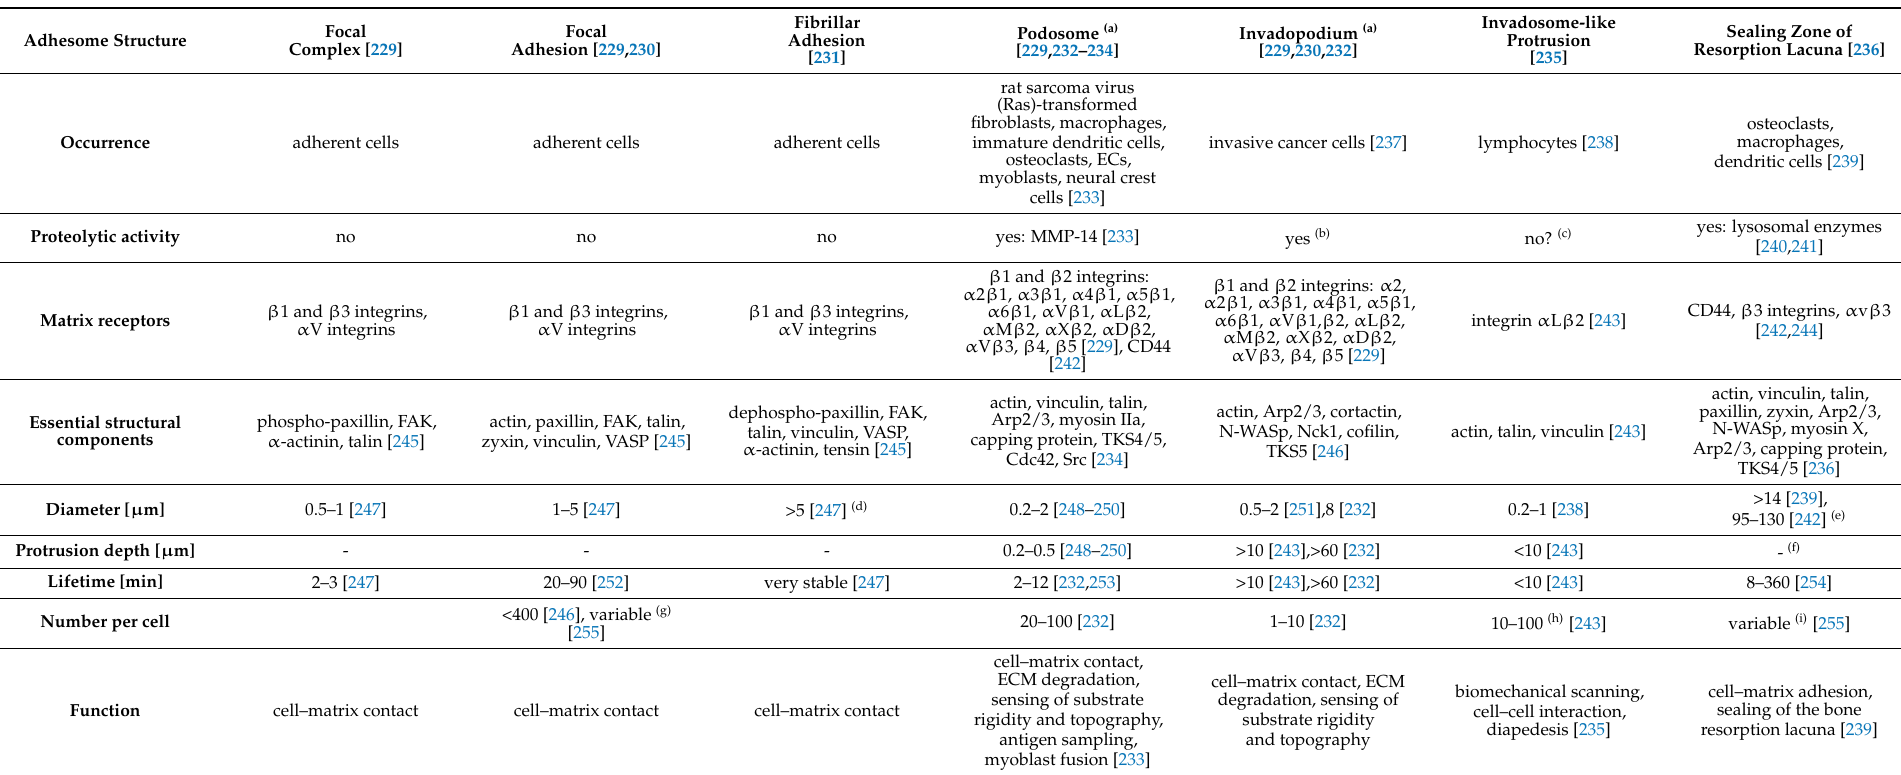
Table 2. Overview of cell–matrix adhesion structures and their involvement in pericellular proteolysis. Cells interact with their surrounding matrix with special adhesome structures. Depending on the function for which different cell types use them, they contain different components. Some adhesome structures possess proteolytic activity. There are also other less common adhesomes, e.g., linear invadosomes and lobopodia, which, for the sake of clarity, are not included in this table